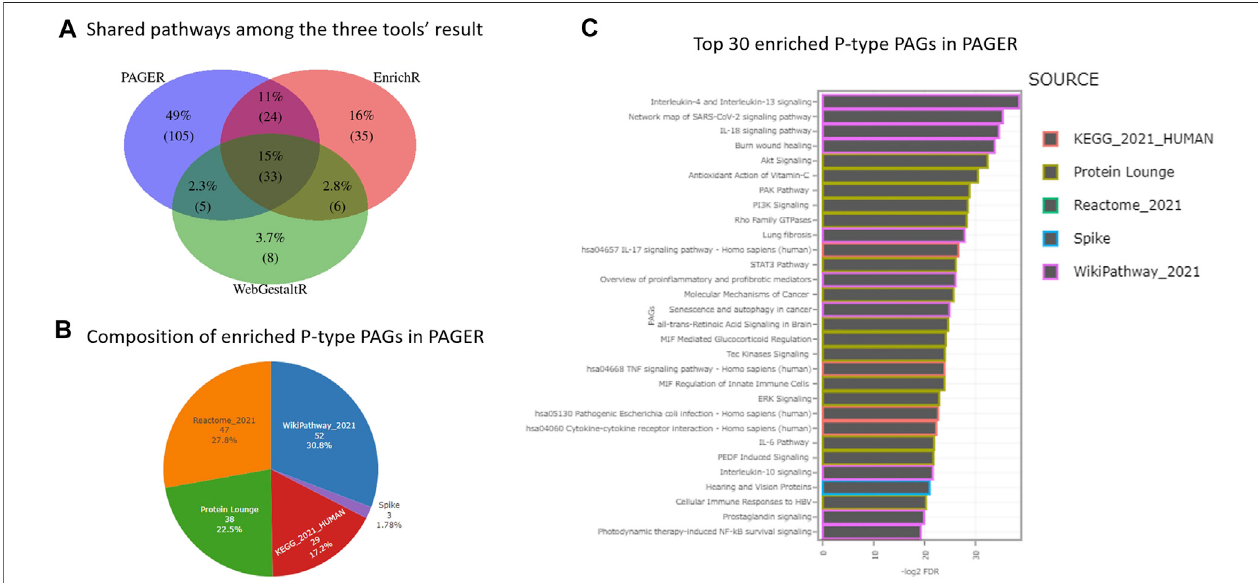
FIGURE2| Theenrichedpathwayresultsformelanomadrugresistant-sensitivepatients. (A) TheconsensuspathwaysamongPAGER,EnrichRandWebGestaltR results. (B) The composition of P-type PAGs enriched in PAGER. (C) The top-30 enriched P-type PAGs are ordered by FDR in PAGER.